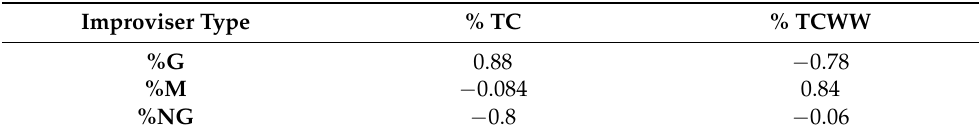
Table 9. Pearson correlation